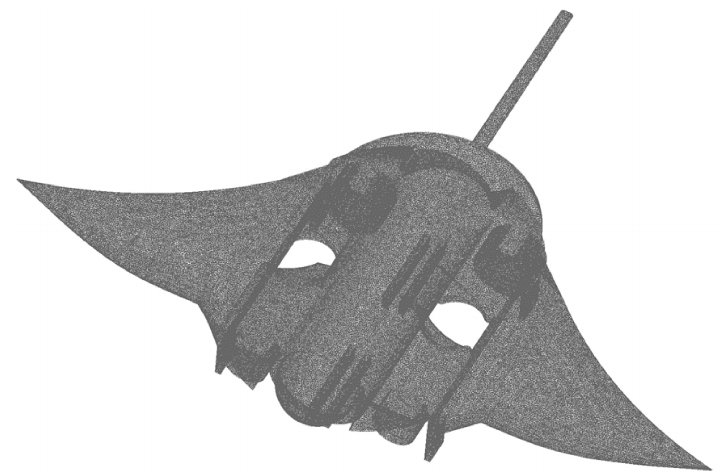
Figure 9. The body mesh of the manta ray